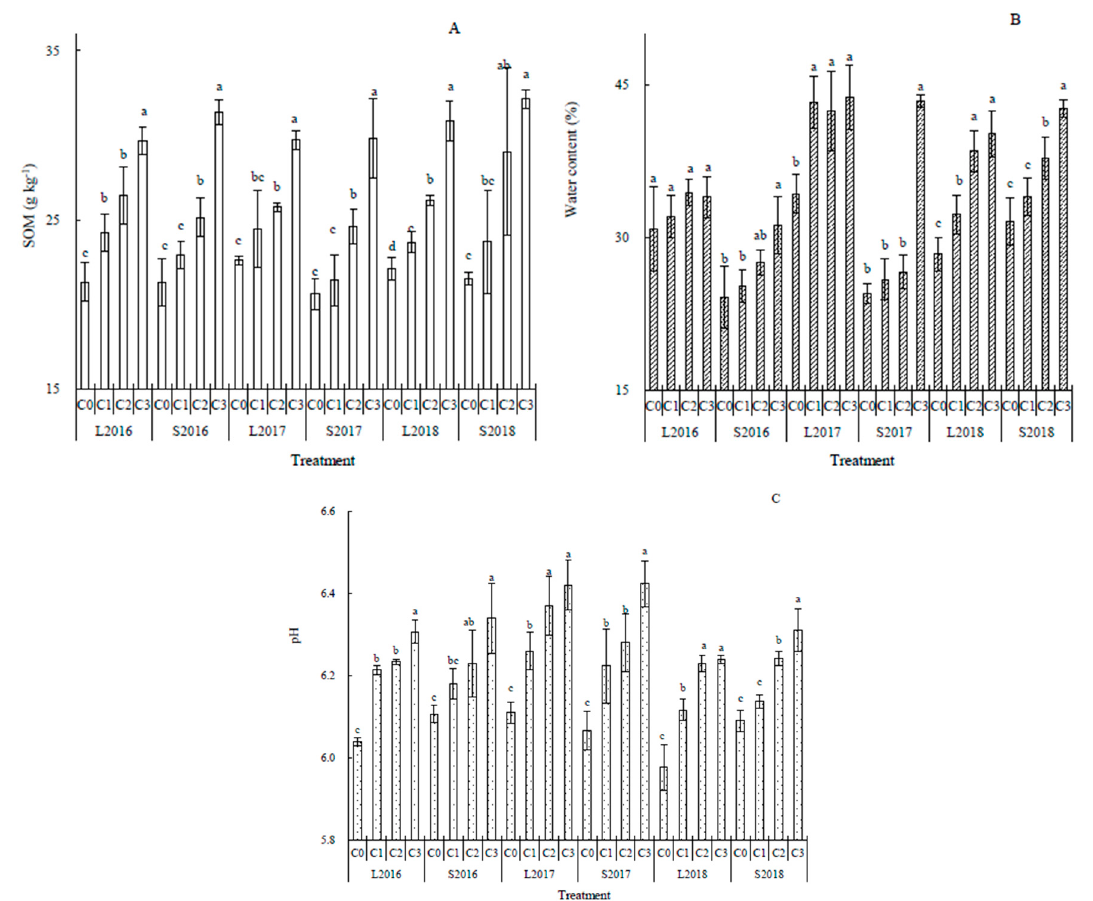
Figure 2. The effect of long- (L) and short-term (S), increasing biochar application rates [0(C0), 10 (C1), 20 (C2) and 40 (C3) t ha − 1 ] on soil ( A ) SOM, ( B ) water content, and ( C ) pH at rice harvest. Different lower-case letters above error bars indicate significant differences between the biochar treatments in either the short- or long-term for a given year [ p < 0.05, Least significant difference (LSD) post-hoc test]. Error bars represent standard deviation of the mean ( n = 3).